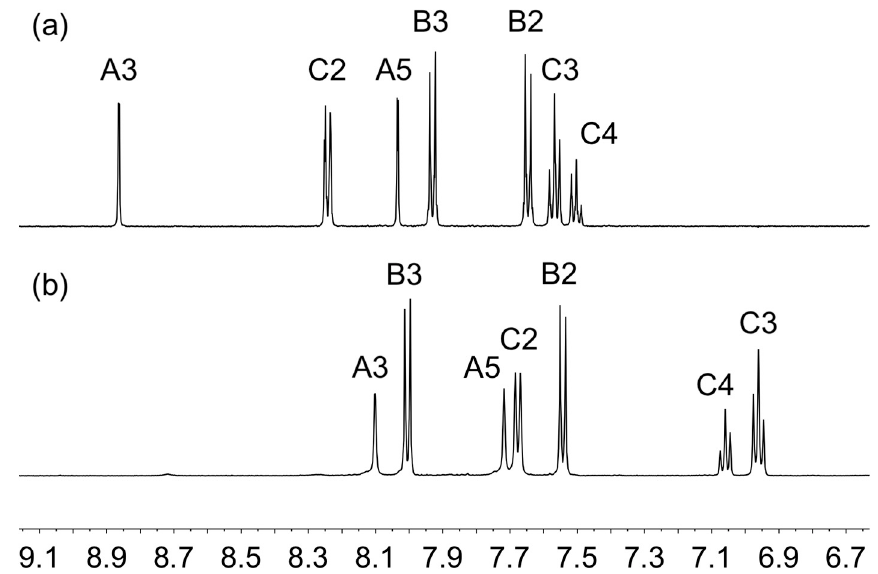
Figure 2. 1 H NMR spectra (500 MHz, 298 K, CD 2 Cl 2 ) of ( a ) 4 and ( b ) [Cu( 4 ) 2 ][PF 6 ].